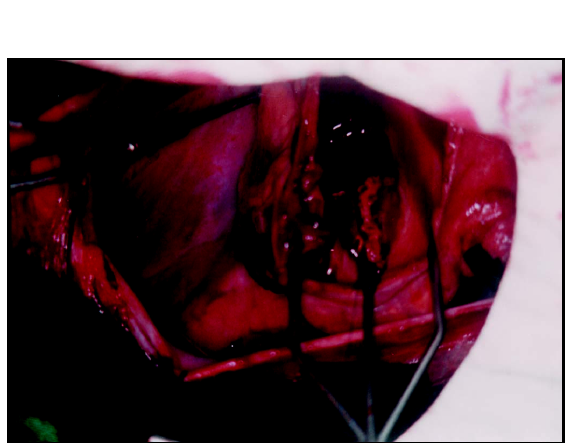
Fig. 1 - Aspecto cirúrgico que demonstra aumento das câmaras cardíacas direitas.